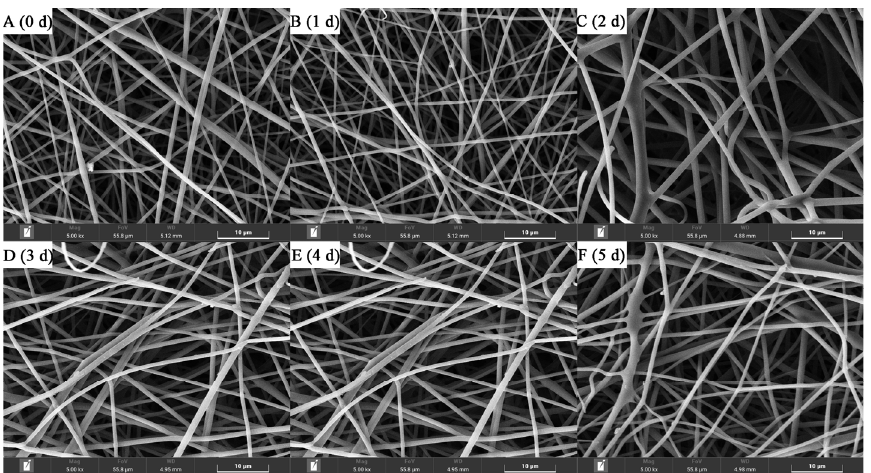
Figure 3. Morphologies of gelatin/zein/glucose nanofiber films after Maillard reactions conducted at 60 °C and 50% RH for 0 (A), 1 (B), 2 (C), 3 (D), 4 (E), and 5 days (F).